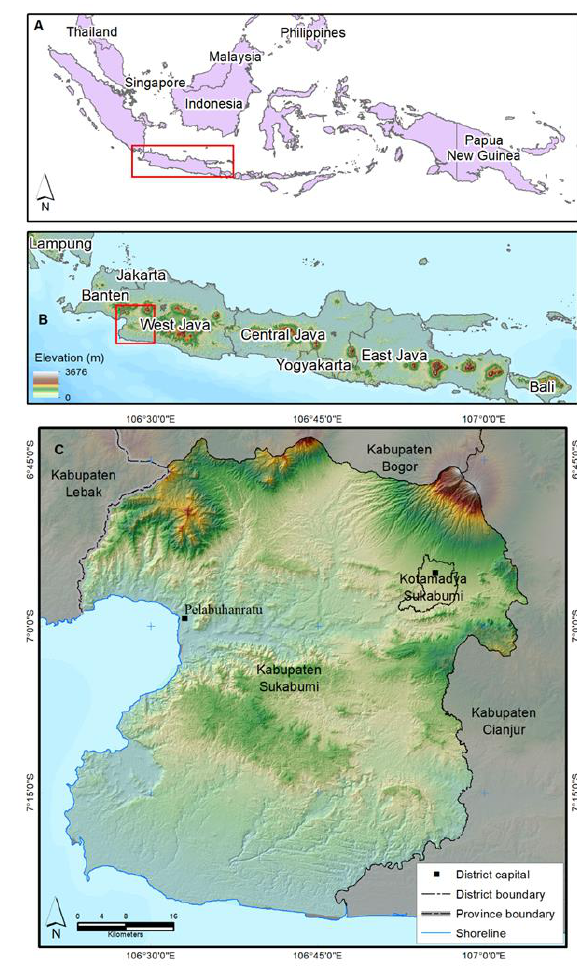
Figure 1. Location of the study area and its